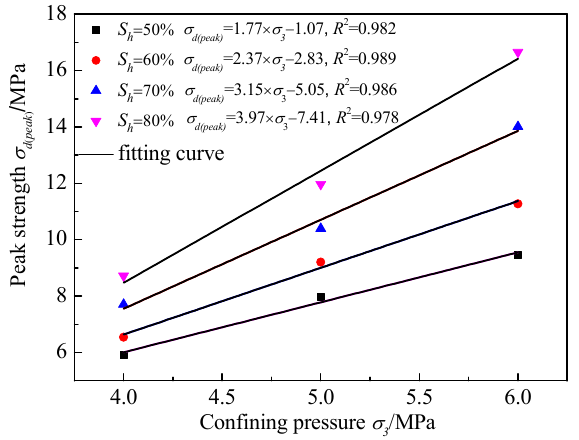
Figure 9. Variation of the peak strength with the confining pressure.